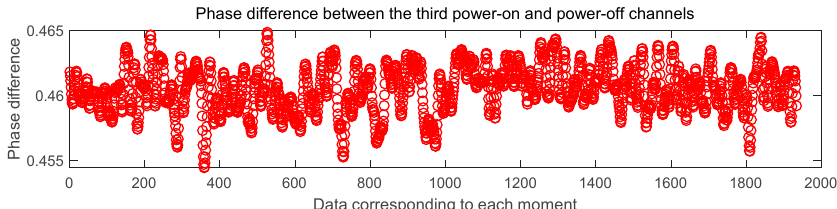
Figure 8. phase difference between B1 channels after three cold starts of the receiver.